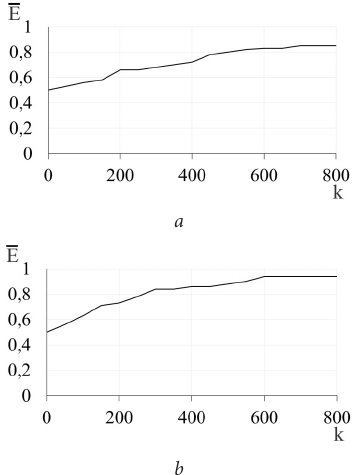
Fig. 2. Graph of changes in the maxima of the averaged criterion (1) in the optimization process A B,l,i and A T,l,i using a learned feature extractor: a – without a teacher; b – with a teacher The analysis of Fig. 2, a shows that during the 800 iter- ations of the swarm search algorithm, the global optimum of the criterion function (1) is found. In this case, the value of criterion (1) for the extractor learned with a teacher is equal to =0.84, which corresponds to a sampling accuracy of